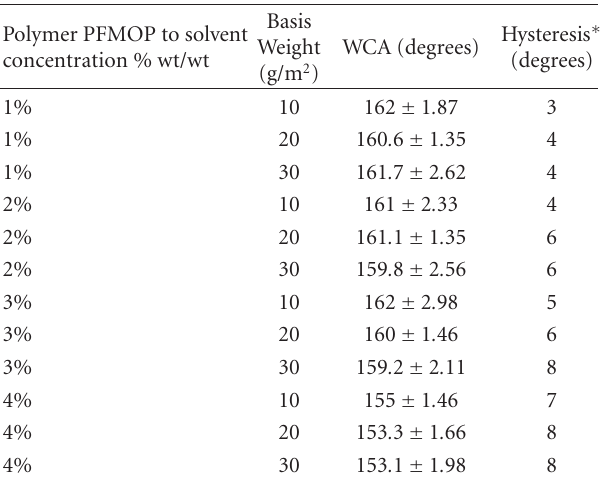
Table 2: WCA and hysteresis